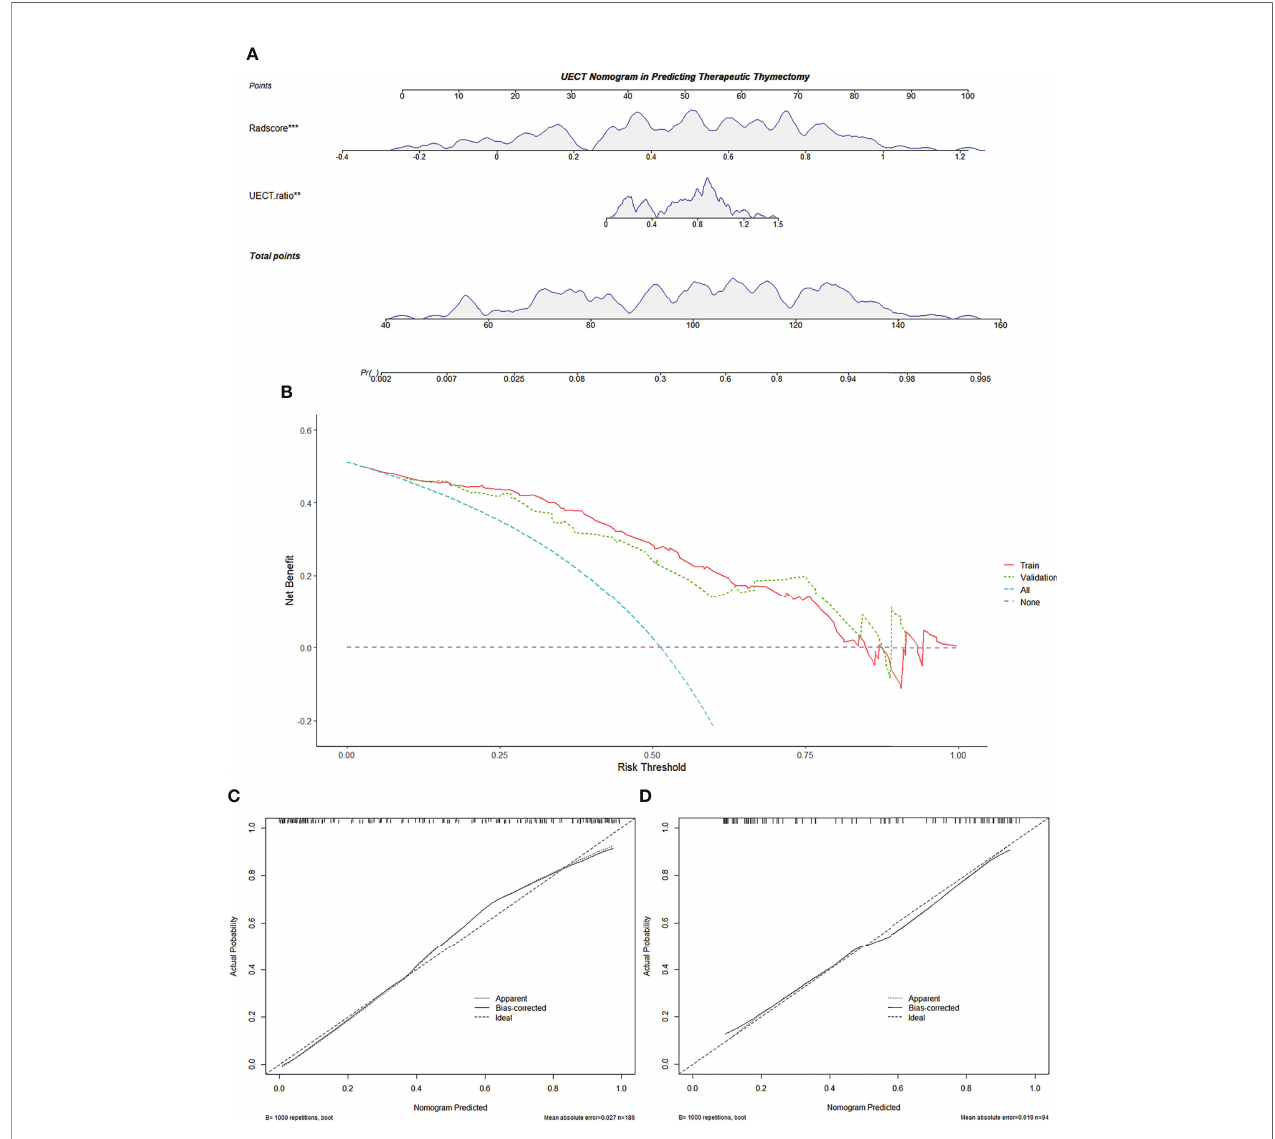
FIGURE 6 | Radiomics-based nomogram was developed in the training set for the UECT model. (A) Radscore and the UECT ratio were incorporated. (B) Decision curve of the nomogram. The y -axis represents the net bene fi t. The x -axis represents the threshold probability. The red line represents the radiomics-based nomogram of the training set. The green line represents the radiomics-based nomogram of the validation set. The blue line represents the assumption that all AMMs are fi t for therapeutic thymectomy. The violet line represents the assumption that all AMMs are not fi t for therapeutic thymectomy. The decision curve demonstrates that if the threshold probability is >5%, using the nomogram for therapeutic thymectomy adds more bene fi t than predicting either all or no patients. (C) Calibration curve of the radiomics-based nomogram in the training set. (D) Calibration curve of the radiomics-based nomogram in the validation set. The 45-degree lines represent perfect predictions. The black dotted lines represent the predictive performance of the nomogram. A closer fi t to the 45-degree line represents a better prediction. AMM, anterior mediastinal mass; UECT, unenhanced computed